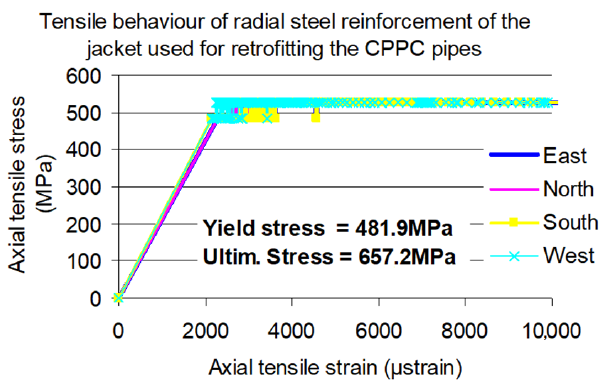
Figure 7. Tensile behaviour of radial reinforcing bar specimens taken from the tested PCCP pipes with the RC jacket. Table 2. Summary details of the original PCCP pipe and the relevant mechanical properties.